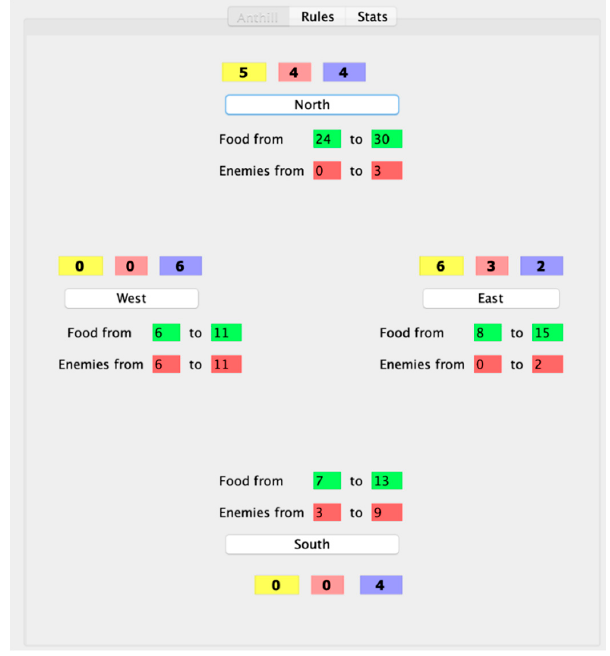
Figure A7. The main screen with ants distributed to the cardinal points.